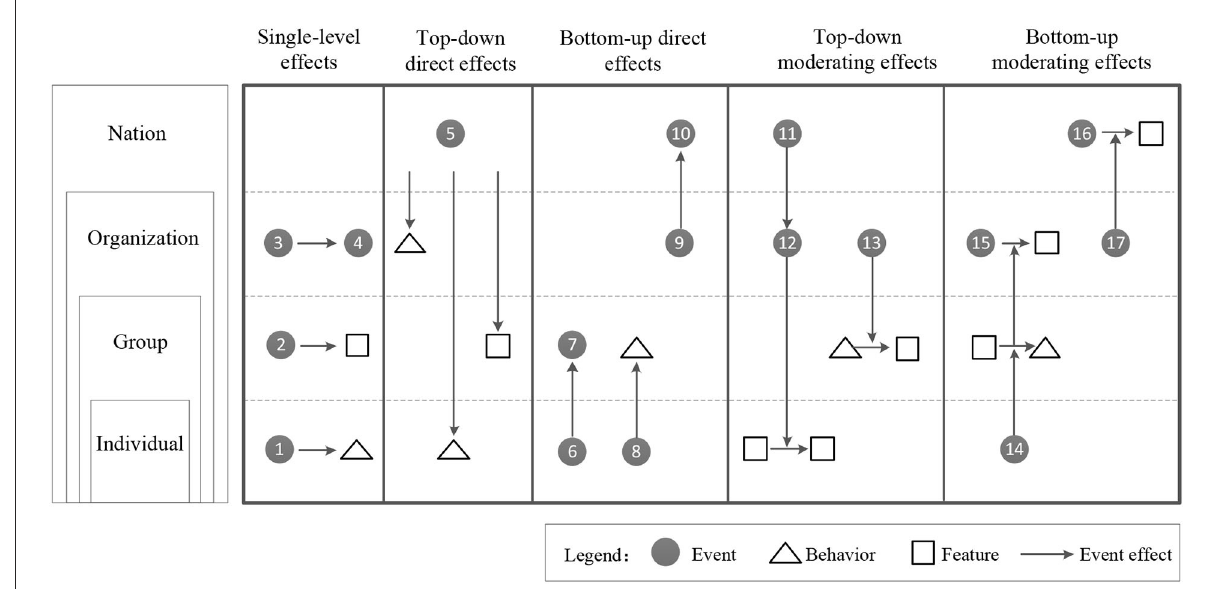
FIGURE1 Typical effects of events on entities in the spatial direction. Typical cases are only illustrative. The numbers of each event in the figure correspond to examples of case numbers used in this